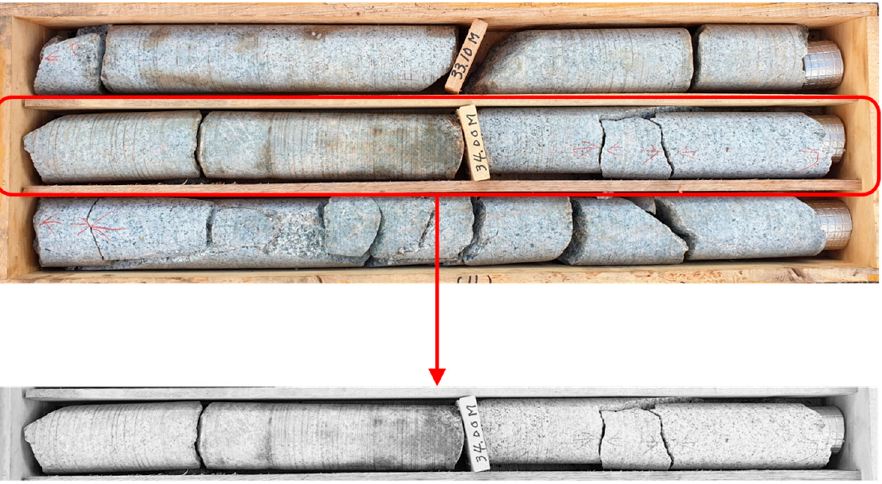
Figure 2. Example of splitting three cores into separate cores and combining the RGB channel into grayscale.